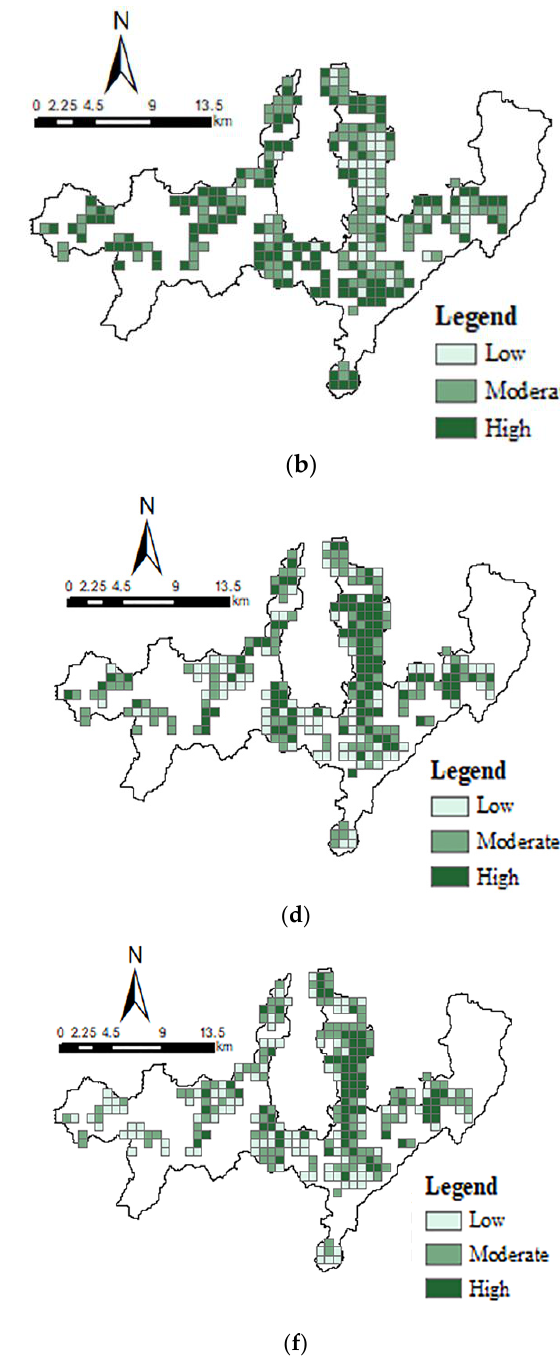
The calculated coupling coordination values were associated with the corresponding sample areas through the tabular-data-linking tool of ArcGIS, and the final spatial distributions of each type of the coupling coordination were obtained (Figure 8).